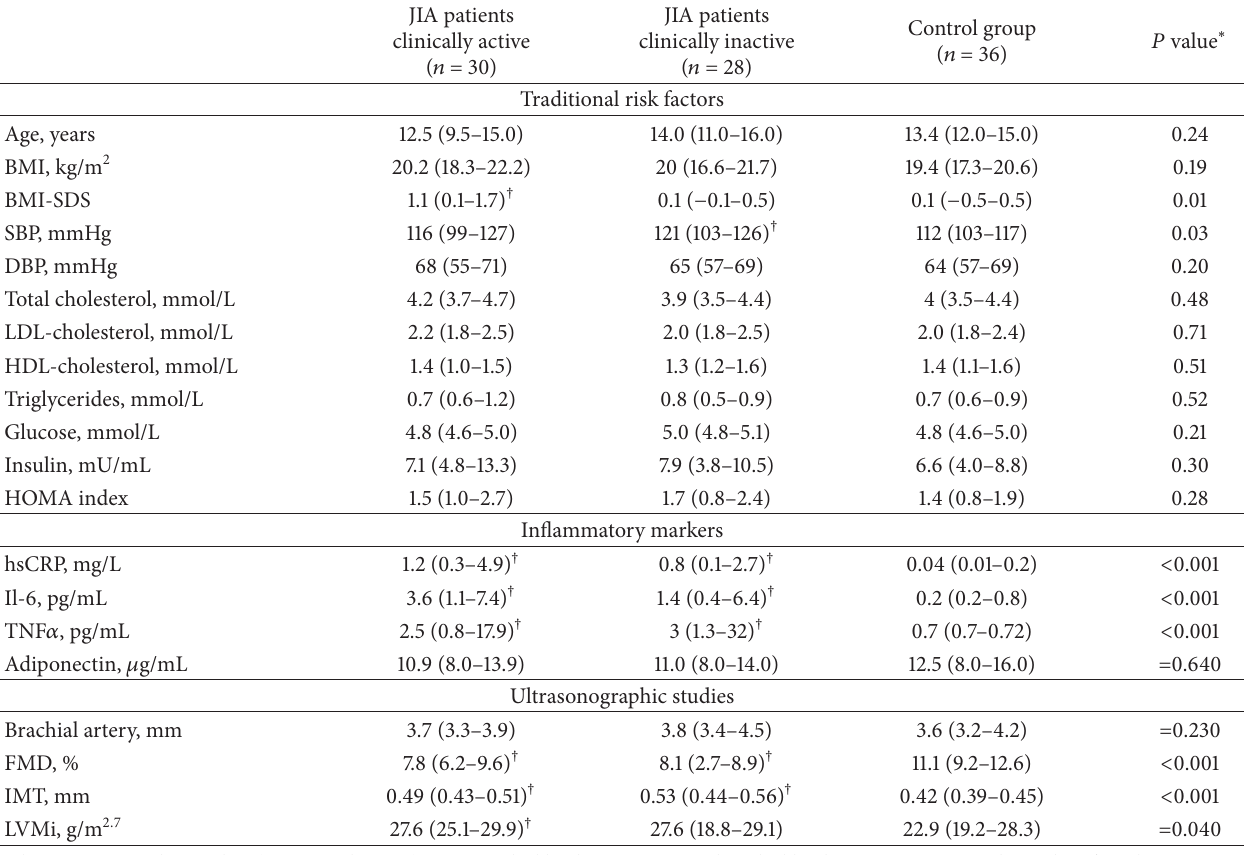
Table 4: Traditional cardiovascular risk factors, selected inflammatory markers, and ultrasonographic evaluation of cardiovascular system in clinically active and inactive juvenile idiopathic arthritis (JIA)